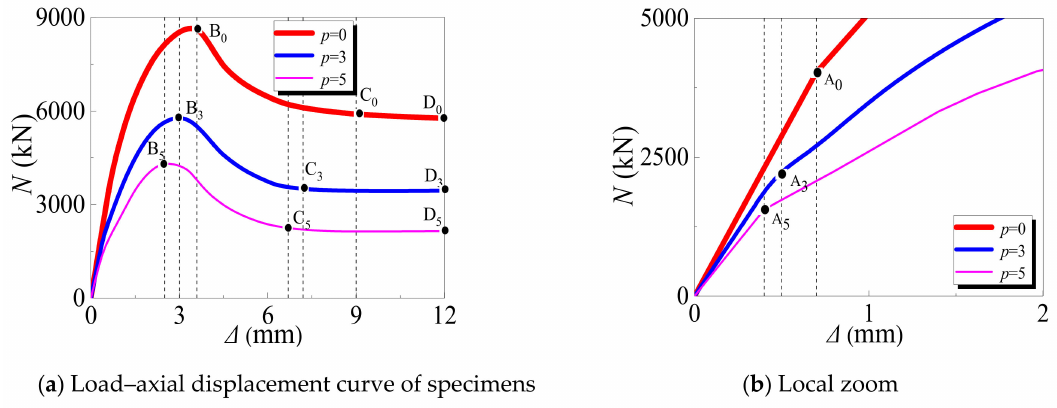
Figure 11. Load–axial displacement curve of